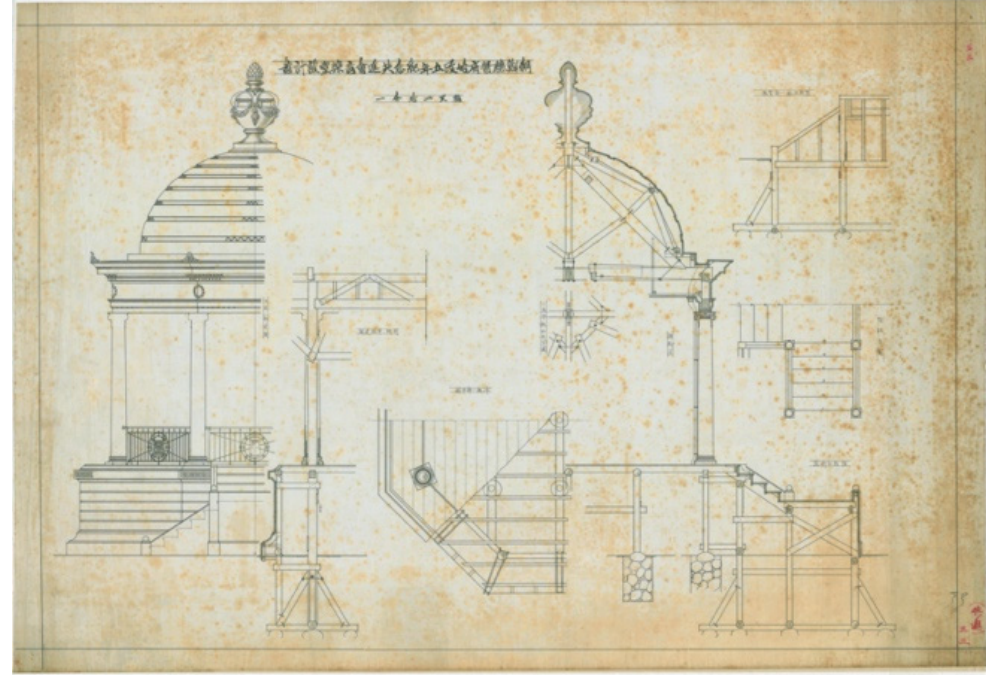
Figure 28. Architectural Drawing for the Concert Hall of the 1915 Joseon Industrial Exhibition— Trusses were used in the Building with a Dome (Source: National Archives of Korea)